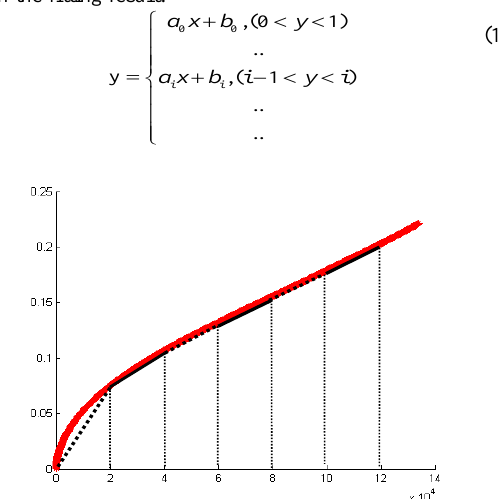
Figure. 3. The relationship between angle distance and